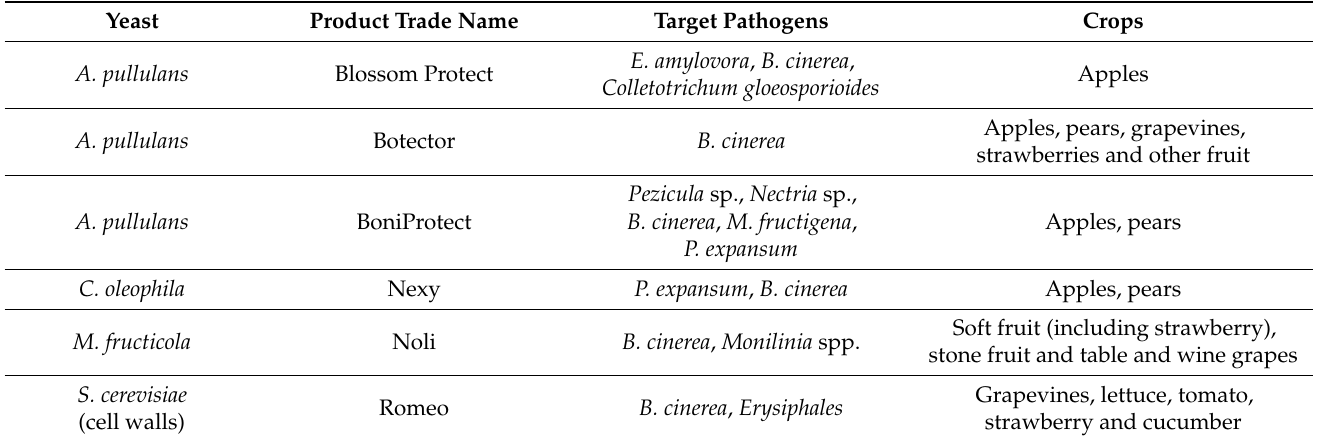
Table 3. Commercially available yeast-based bioproducts for the control of plant